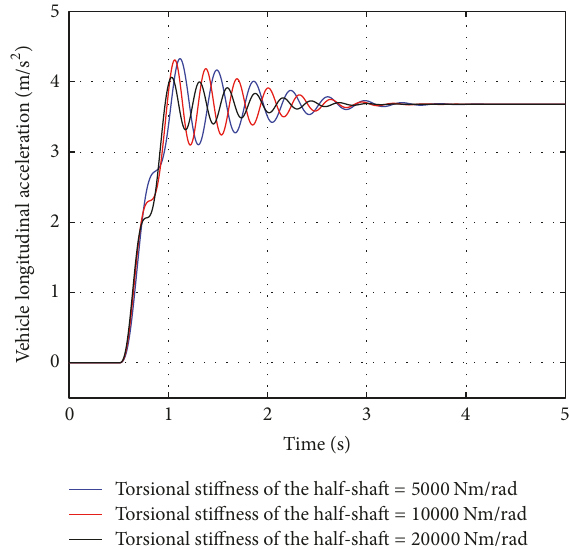
Figure 8: Sensitivity analysis: effect of the variation of the torsion stiffness 𝑘 hs of the